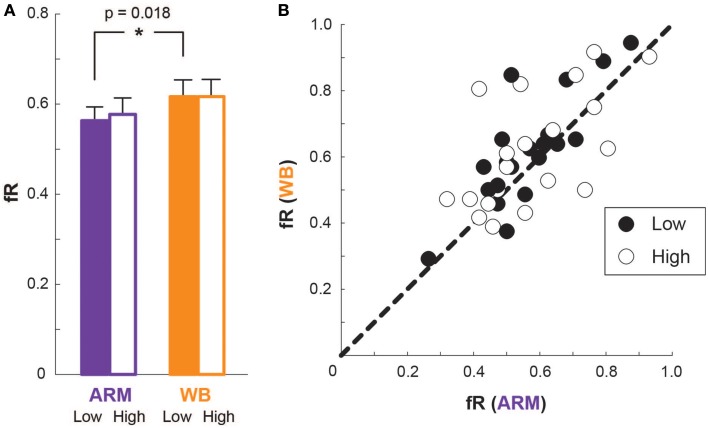
Frequency of risky choices. (A) Mean frequency of risky choices (fR) for ARM and WB at Low elevation (filled bars) and at High elevation (outlined bars). (B) Each subject's fR in the ARM condition compared with that in the WB condition, at Low elevation (filled circles) and at High elevation (outlined circles). A data point on the line of unity indicates that the subject chose the same number of risky lotteries in both motor tasks.